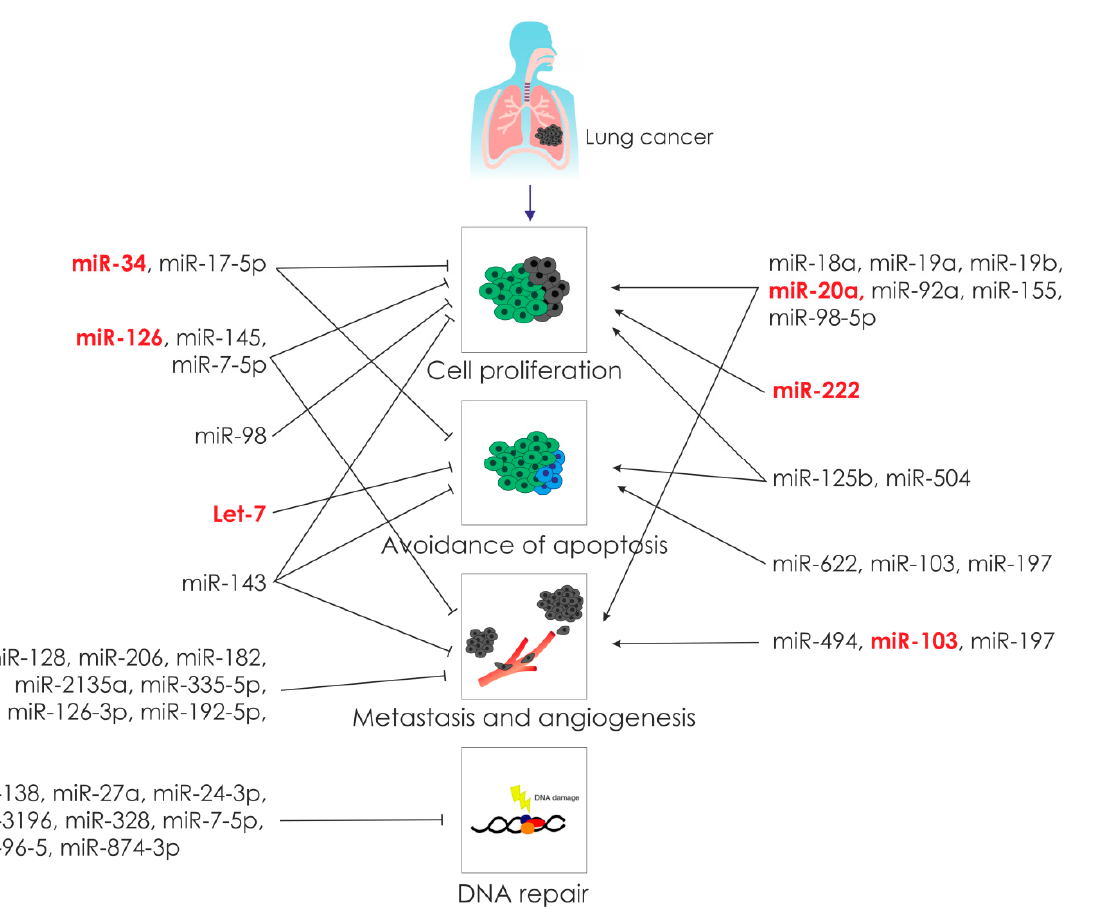
Figure 1. Cellular aspects of lung carcinogenesis with microRNA regulations (microRNAs whose expression profile changed under the influence of asbestos, are highlighted in red).